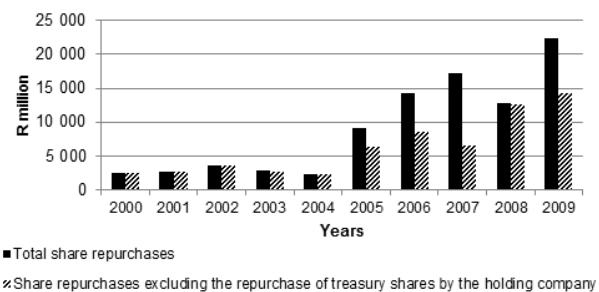
Figure 1: Share repurchase activity (adjusted to reflect 1999 prices)